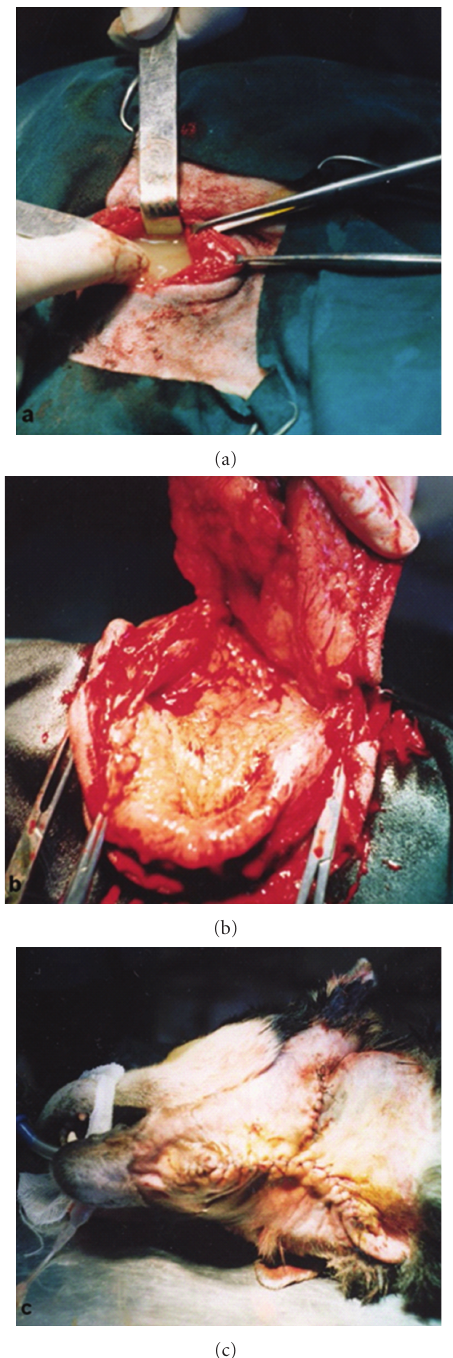
Figure 3: Intraoperative and postoperative views of the surgical procedure. Saliva was encountered at the incision site (a) and the surrounding reactive connective tissue is being excised (b). The cervical region resumes normality following the surgery